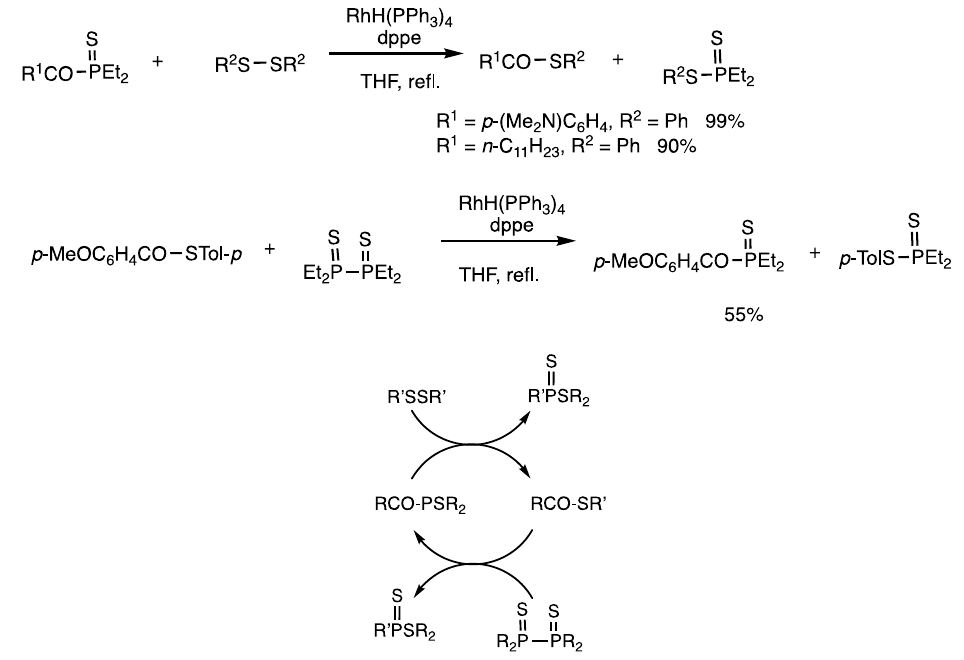
Scheme 14. Interconversion reactions between acylphosphine sulfides and thioesters.